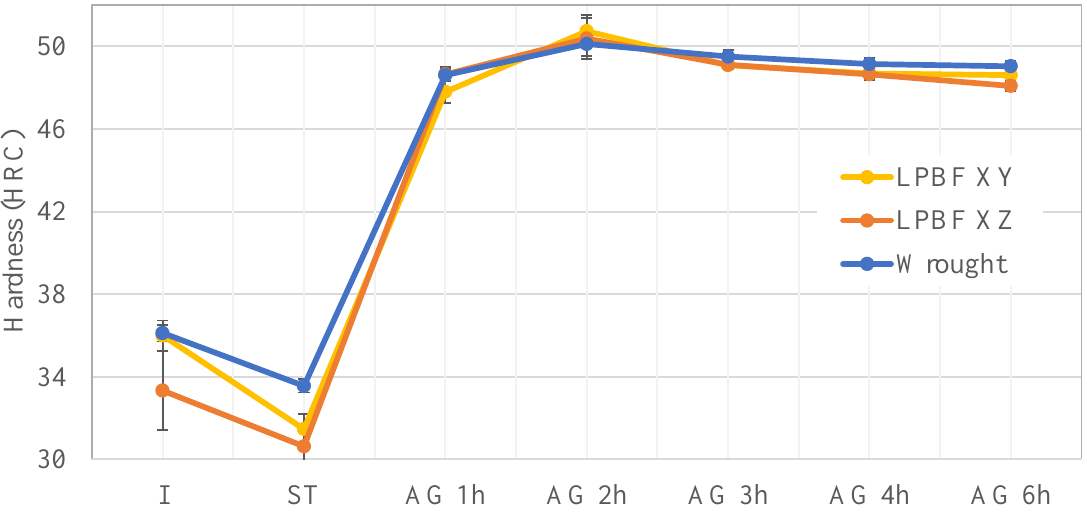
Figure 3. Hardness of the LPBF and wrought alloys as a function of processing state.